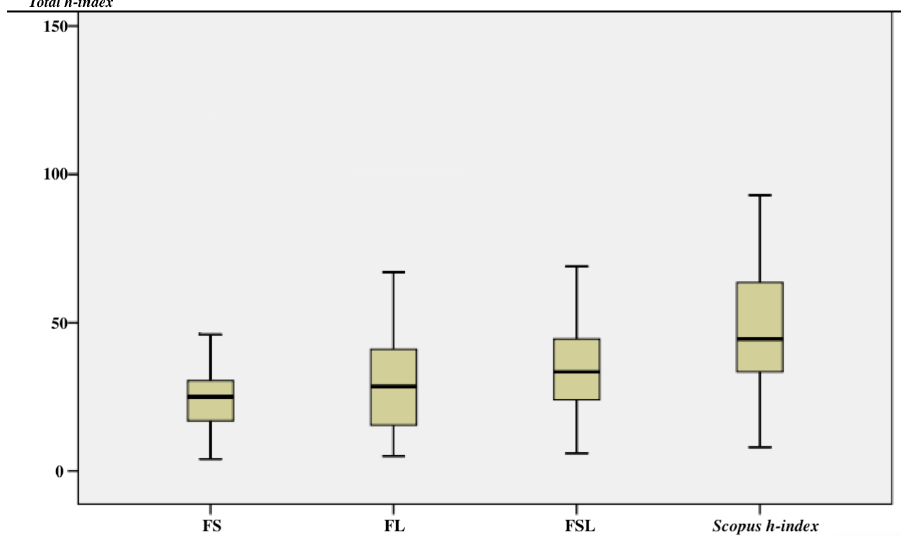
Figure 2. A box plot shows the modified h-index values (± standard deviation) for all authors considered in this study. The total h-index retrieved from Scopus is the highest of the four classifications.